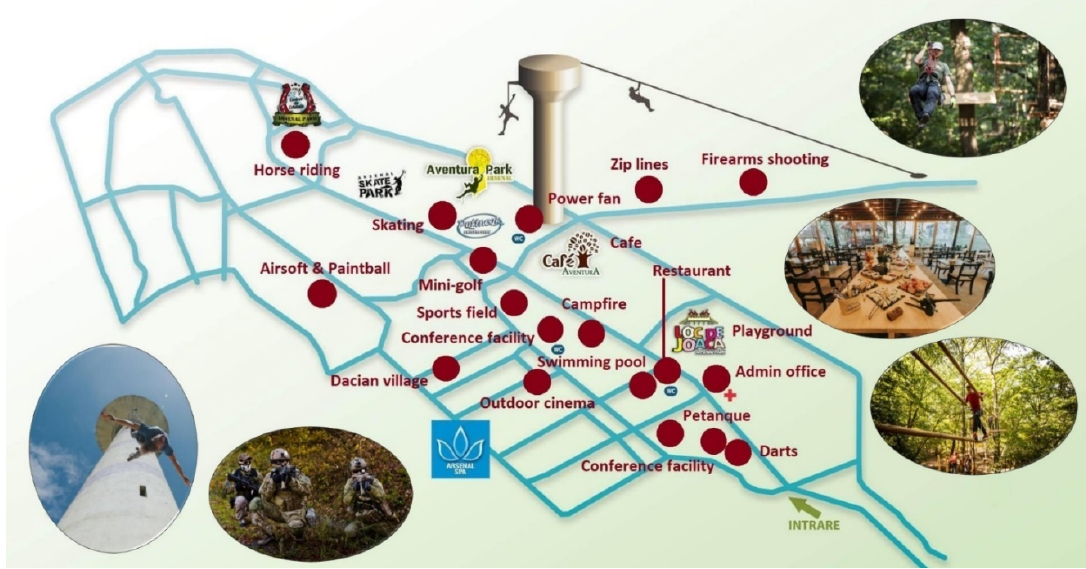
Figure A2. Map of Arsenal Park. (Source: Translated and adapted from https://arsenalpark.ro/ (accessed on: 15 September 2021)).